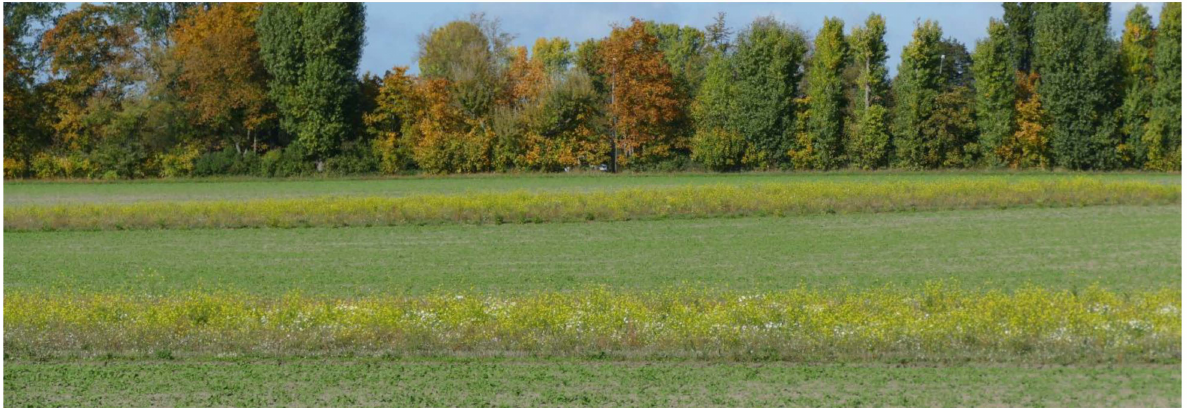
Figure 3. Production-integrated compensation in agriculture: skylark strips as species protection measures (October 2022, G.F.M.